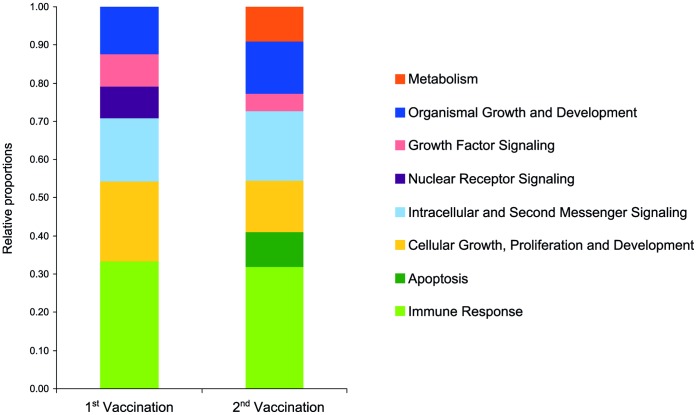
Most affected biofunctions within 24 hours after the first and after the second vaccination.Segments of the respective bars for the first and the second vaccination represent the relative frequencies of IPA biofunctional categories superior to canonical pathways that are most significant at 2 h, 4 h, 8 h and 24 h after immunization.